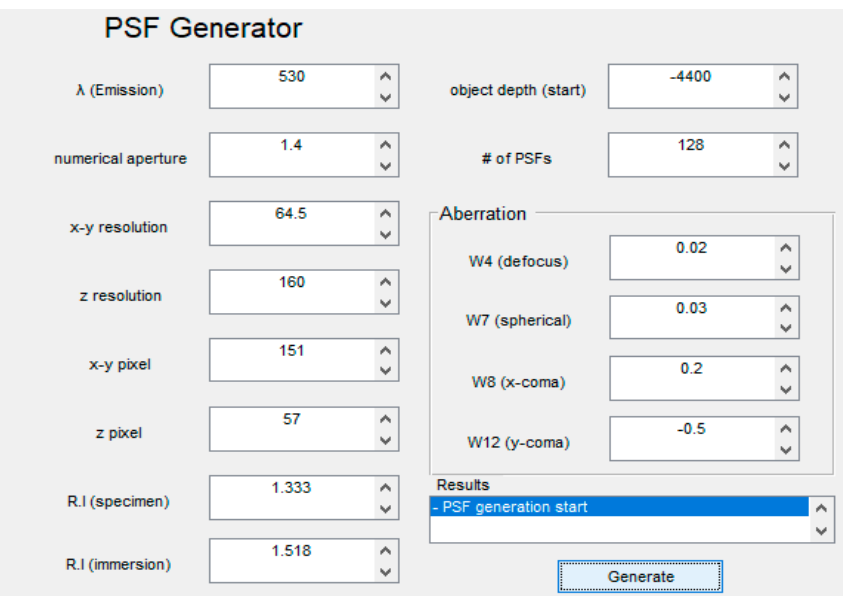
Figure 4. DVDeconv PSF Generator GUI.